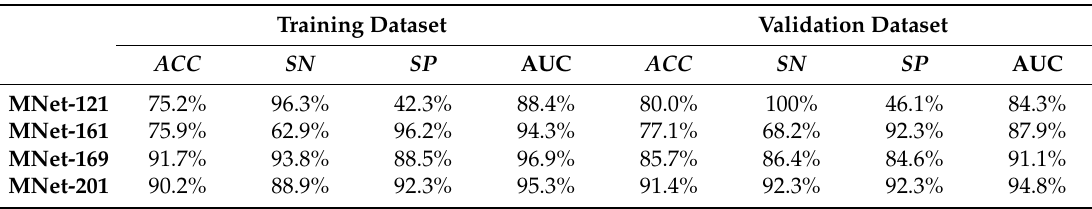
Table 5. World Health Organization (WHO) grade status prediction performance.